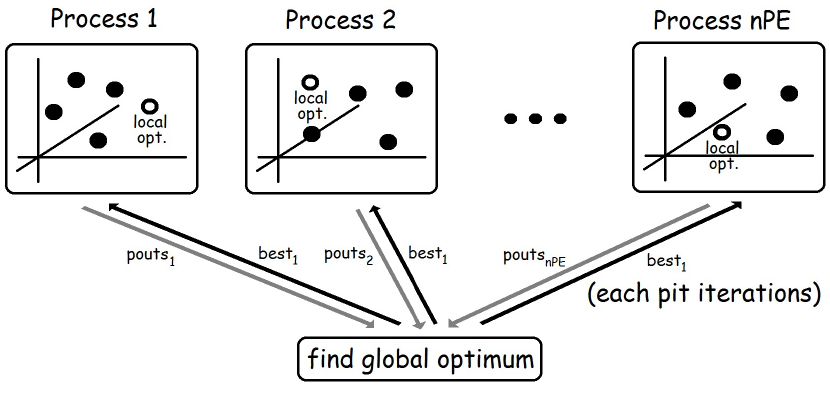
Figure 2. Basic structure of the second